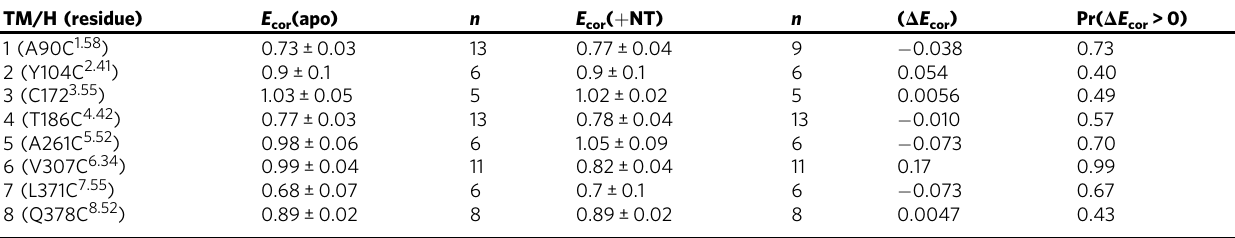
Table 1 Ensemble interprotomer FRET TM/H